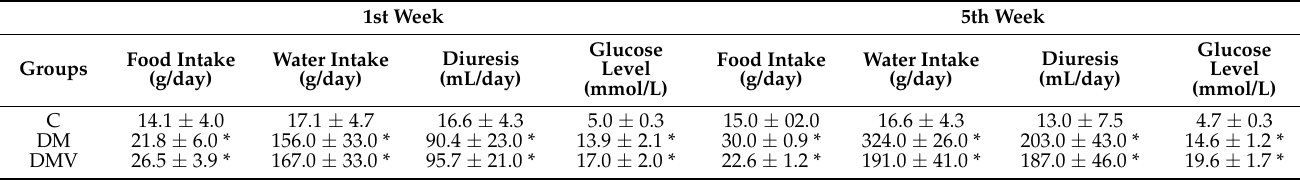
Table 1. Food and water intake, diuresis, and glucose